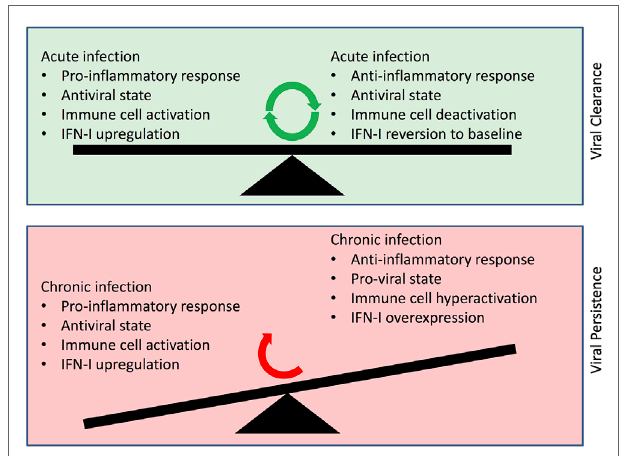
FiGURe 1 | Depiction of changes in Type i interferon (iFn-i) roles in viral clearance vs. viral persistence . (Upper panel) Balance of functional IFN-I signaling, which results in viral clearance within the context of an acute infection. (Lower panel) Dysfunctional IFN-I signaling in the face of a chronic infection resulting in aberrant immune cell activation and viral